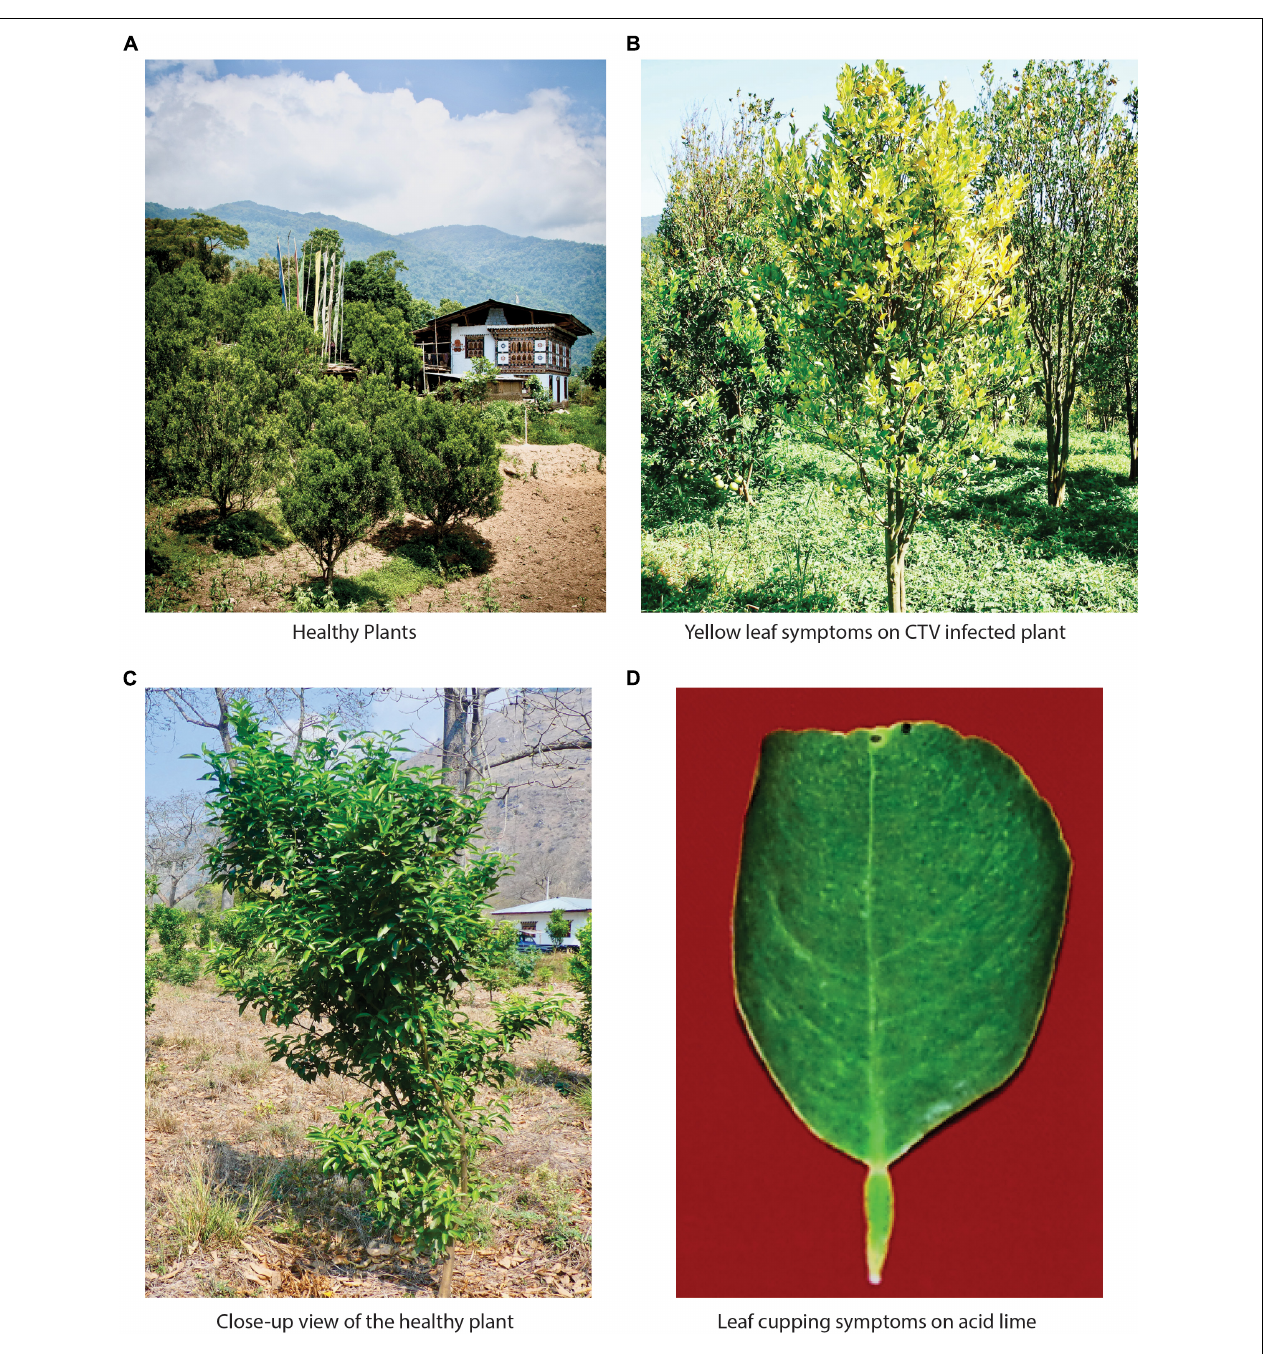
FIGURE 1 | Bhutan represents the richest diversity of tristeza variants found across the world. (A) Citrus cultivation scenario in Bhutan. Almost every household grows oranges in their backyard and surround their houses. (B) Typical CTV-infected plant in the field showing the yellowing of leaves. (C) A closer view of the healthy plant in the field. (D) One of the typical symptoms of a severely tristeza-infected plant is leaf cupping on acid lime.